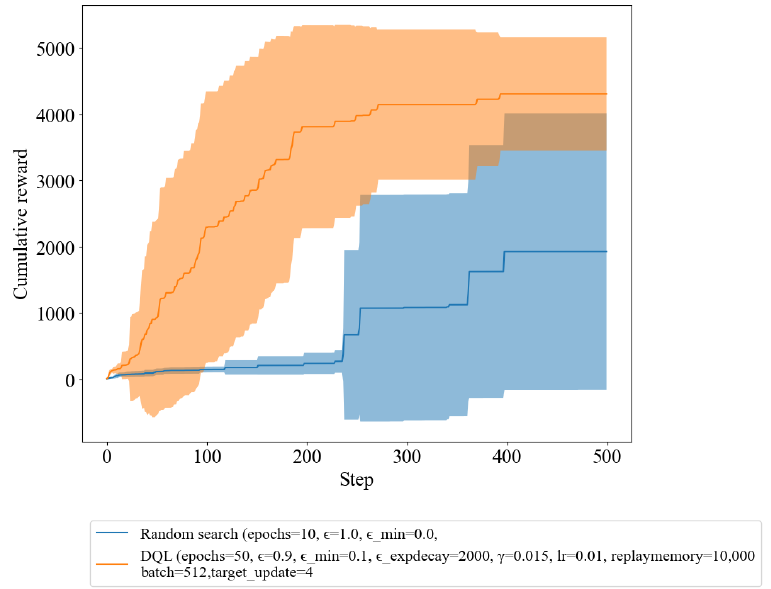
Figure 1. Reward of random search and DQL with fixed epsilon and epsilon Decay.